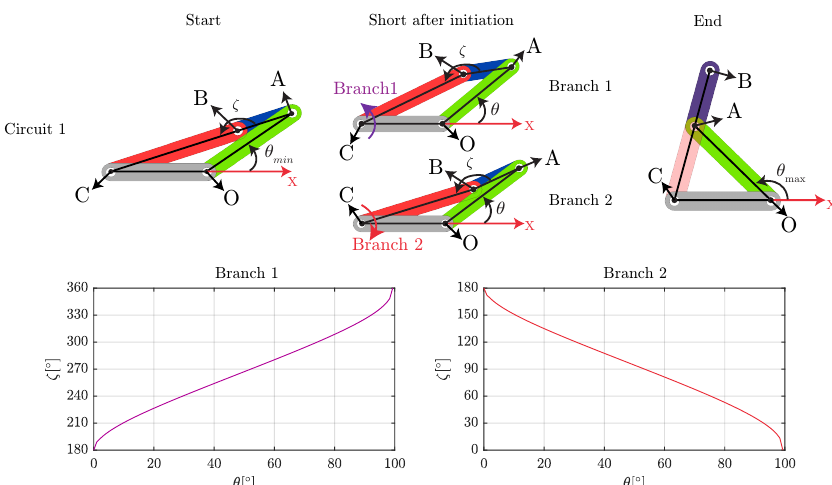
Figure 9. An example of a four-bar mechanism that has two connecting branches on the first circuit. It is shown that moving the mechanism from θ min until θ max corresponds to a movement of the transmission angle on Branch 1 from 180° to 360°, while on Branch 2, from 180° to 0°.